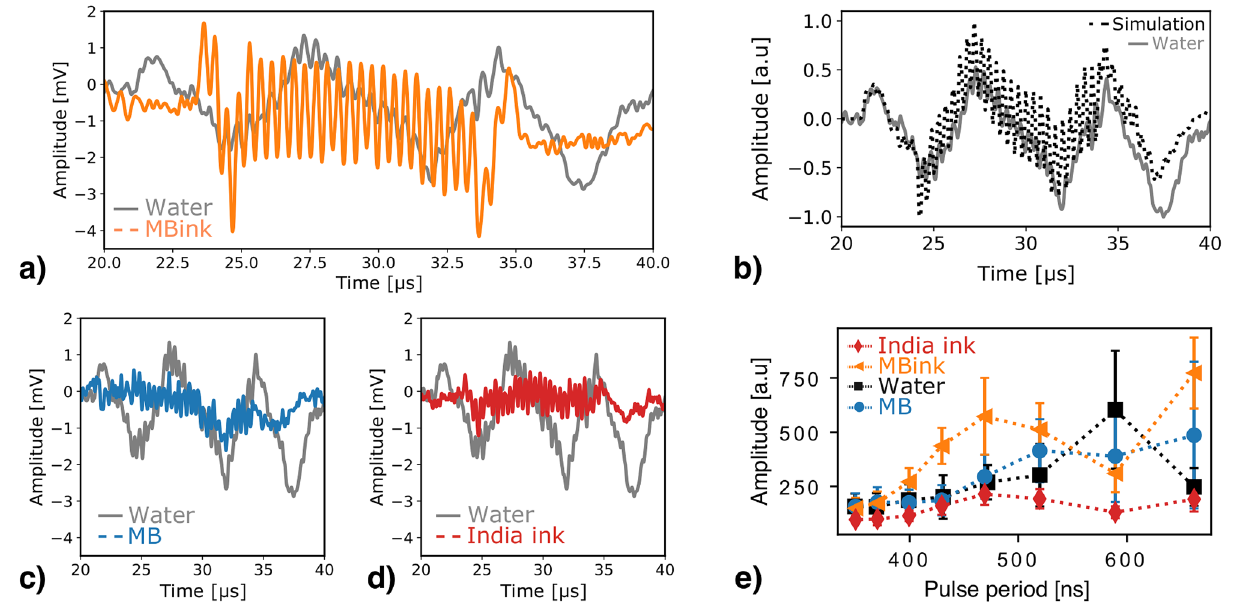
Figure 4. Evolution of the ionoacoustic signals with the pulsing period of the spread-out Bragg peak. Ionoacoustic signals measured for the spread-out proton beam and 25-cycle proton pulse of 400 ns period in water (gray) compared to ( a ) SonoVue microbubbles / India ink mixture in water (orange), ( b ) simulated signal in water (black dashed line), ( c ) SonoVue microbubbles in water (blue), ( d ) India ink in water (red). All the experimental measurements have been averaged over 3000 acquisitions. ( e ) Evolution of the signal amplitude for irradiation with the ripple filter depending on the pulse period. The amplitude was extracted from the Fourier transformed signals at the temporal excitation frequency to disentangle the high and low frequency components of the signal. All the experimental measurements have been averaged over 3000 acquisitions and filtered using PyWavelets Python package. All error bars correspond to measurement uncertainties obtained from 30 consecutive measurements and given with a confidence level of